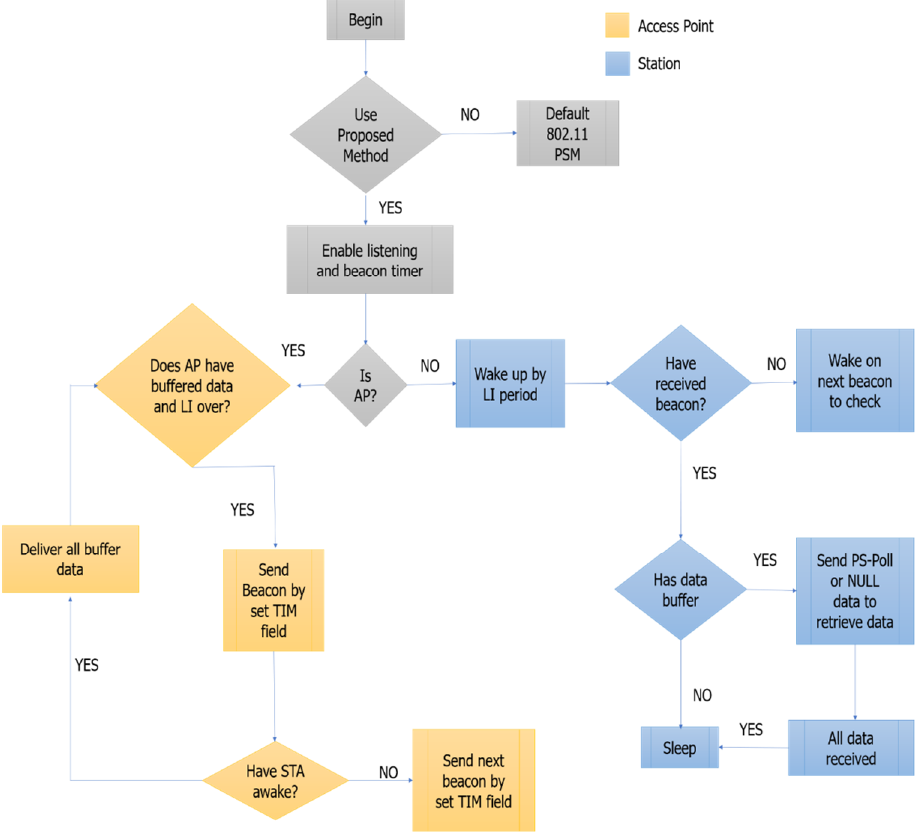
Figure 13. Data Delivery Flow Chart.